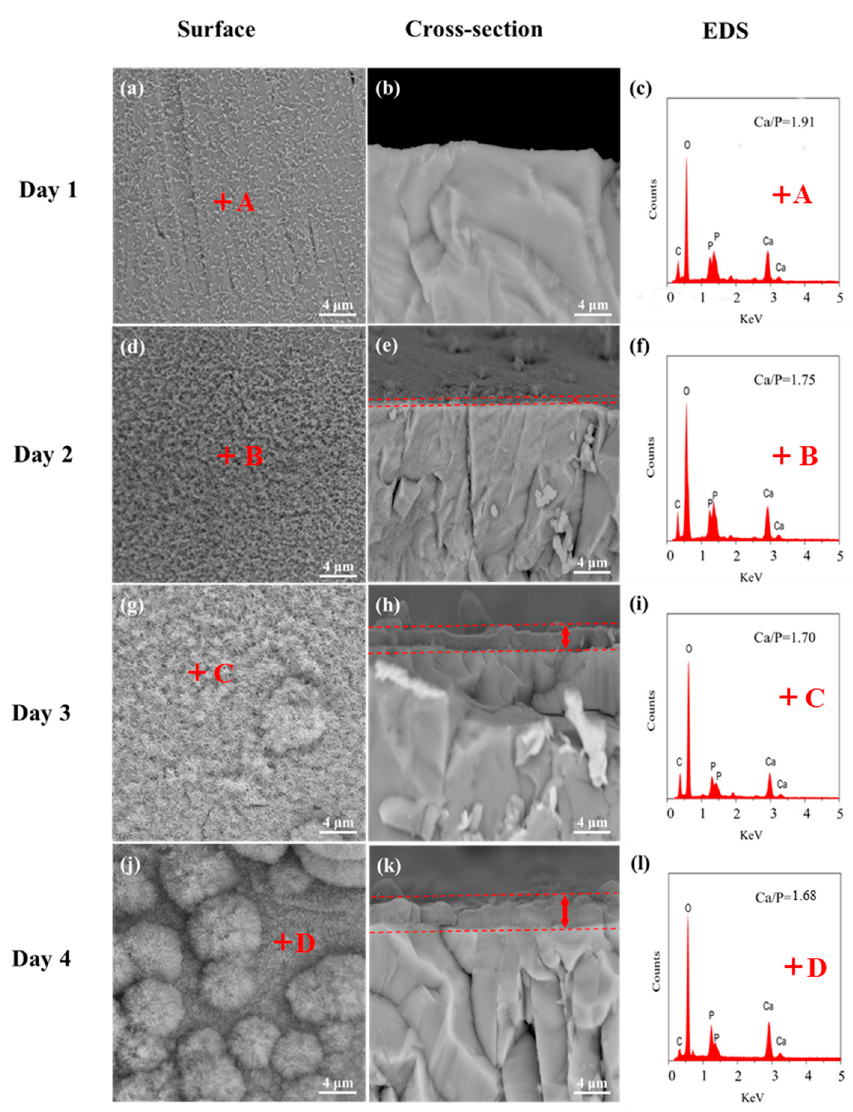
Figure 5. SEM images (surface and cross-section) and EDS traces of the TTCP porous scaffolds after soaking in SBF for different durations: ( a - c ) one day, ( d - f ) two days, ( g - i ) three days, and ( j - l ) four days.